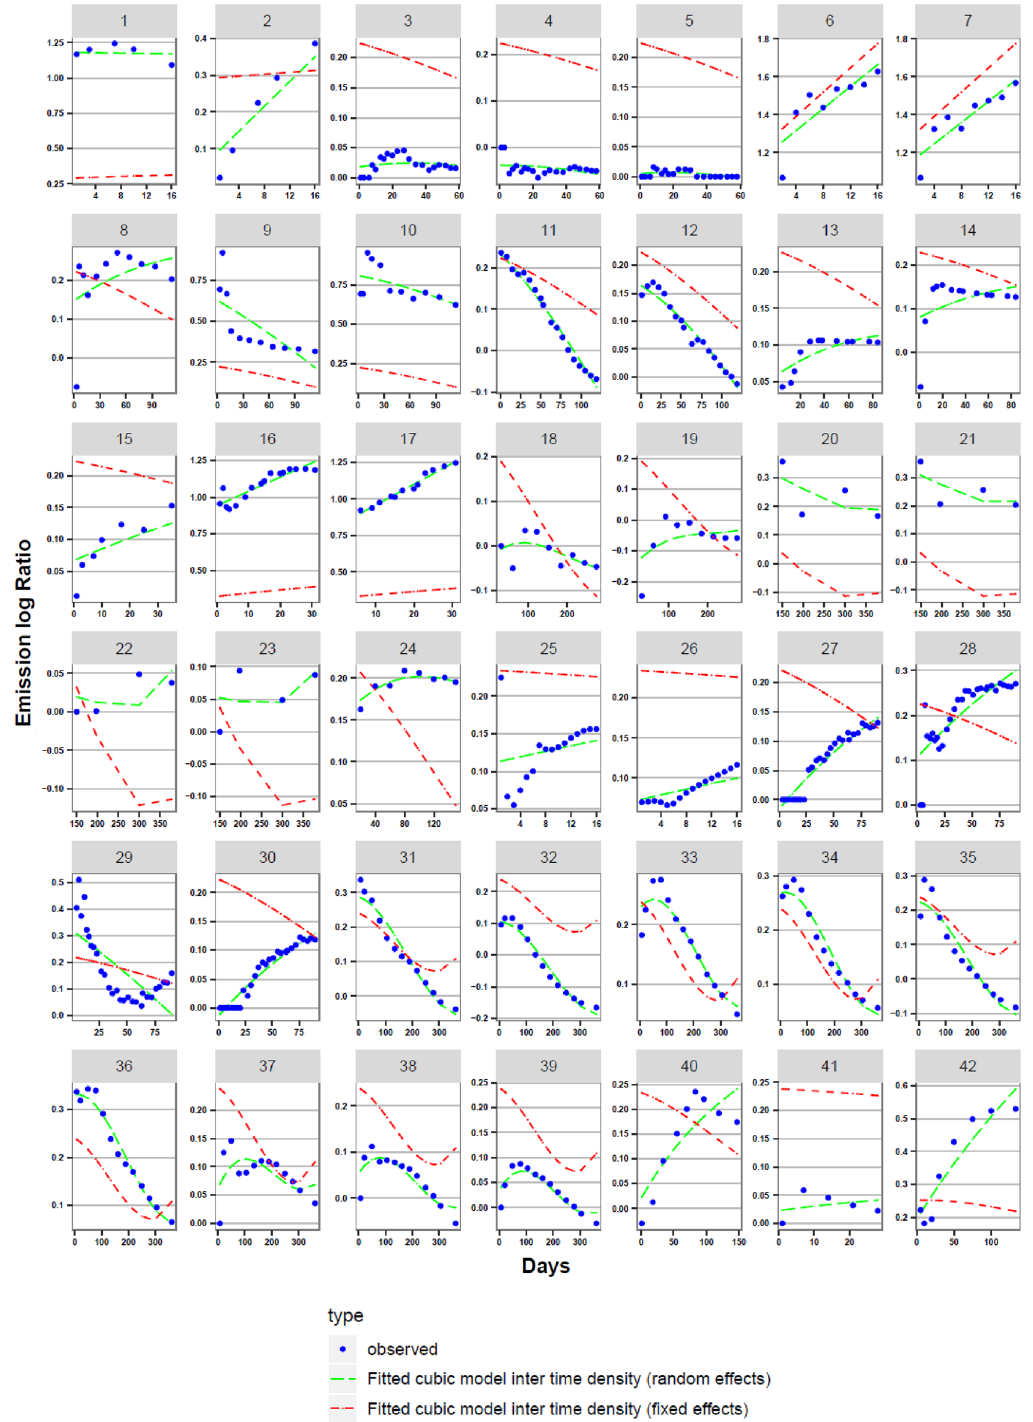
Figure 1. Evolution of the log ratio of CO 2 emissions with and without EW with time in the 42 experimental situations; comparison between experimental data (blue curve) and both mathematical models: one model with fixed temporal effects (red curve) and one model with the random temporal effects (green curve). The statistical parameters of both models are given in Table 2. The corresponding publication for each figure is: Figs. 1, 2 18 , Figs. 3–5 31 , Figs. 6, 7 32 , Figs. 8–10 7 , Figs. 11, 12 19 , Figs. 13, 14 33 , Fig. 15 30 , Figs. 16, 17 34 , Figs. 18, 19 27